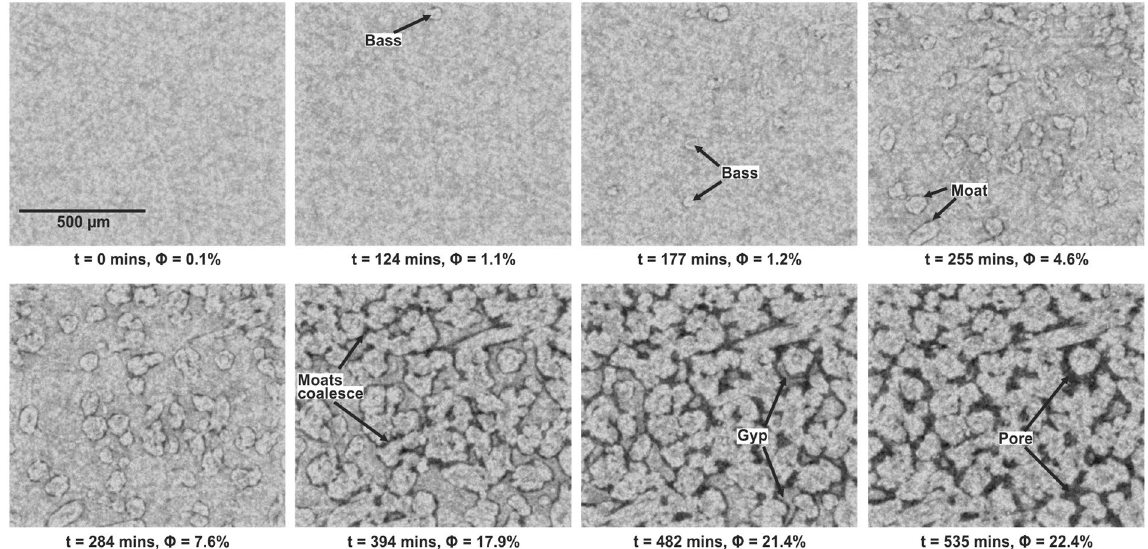
Figure 1. Time-series microtomographic reconstructions of the dehydrating gypsum sample. The first bassanite grains are observed after 124 minutes. The new grains are evenly distributed throughout the sample and grow surrounded by moats of porosity which appear black in the reconstructions. The grains grow larger and the porosity ( Φ ) increases as the moats get wider. At 394 minutes the grains begin to impinge on each other and the porous moats start to coalesce. By 482 minutes the bassanite grains isolate the remaining pockets of gypsum which is consumed in the reaction and the pores expand into this